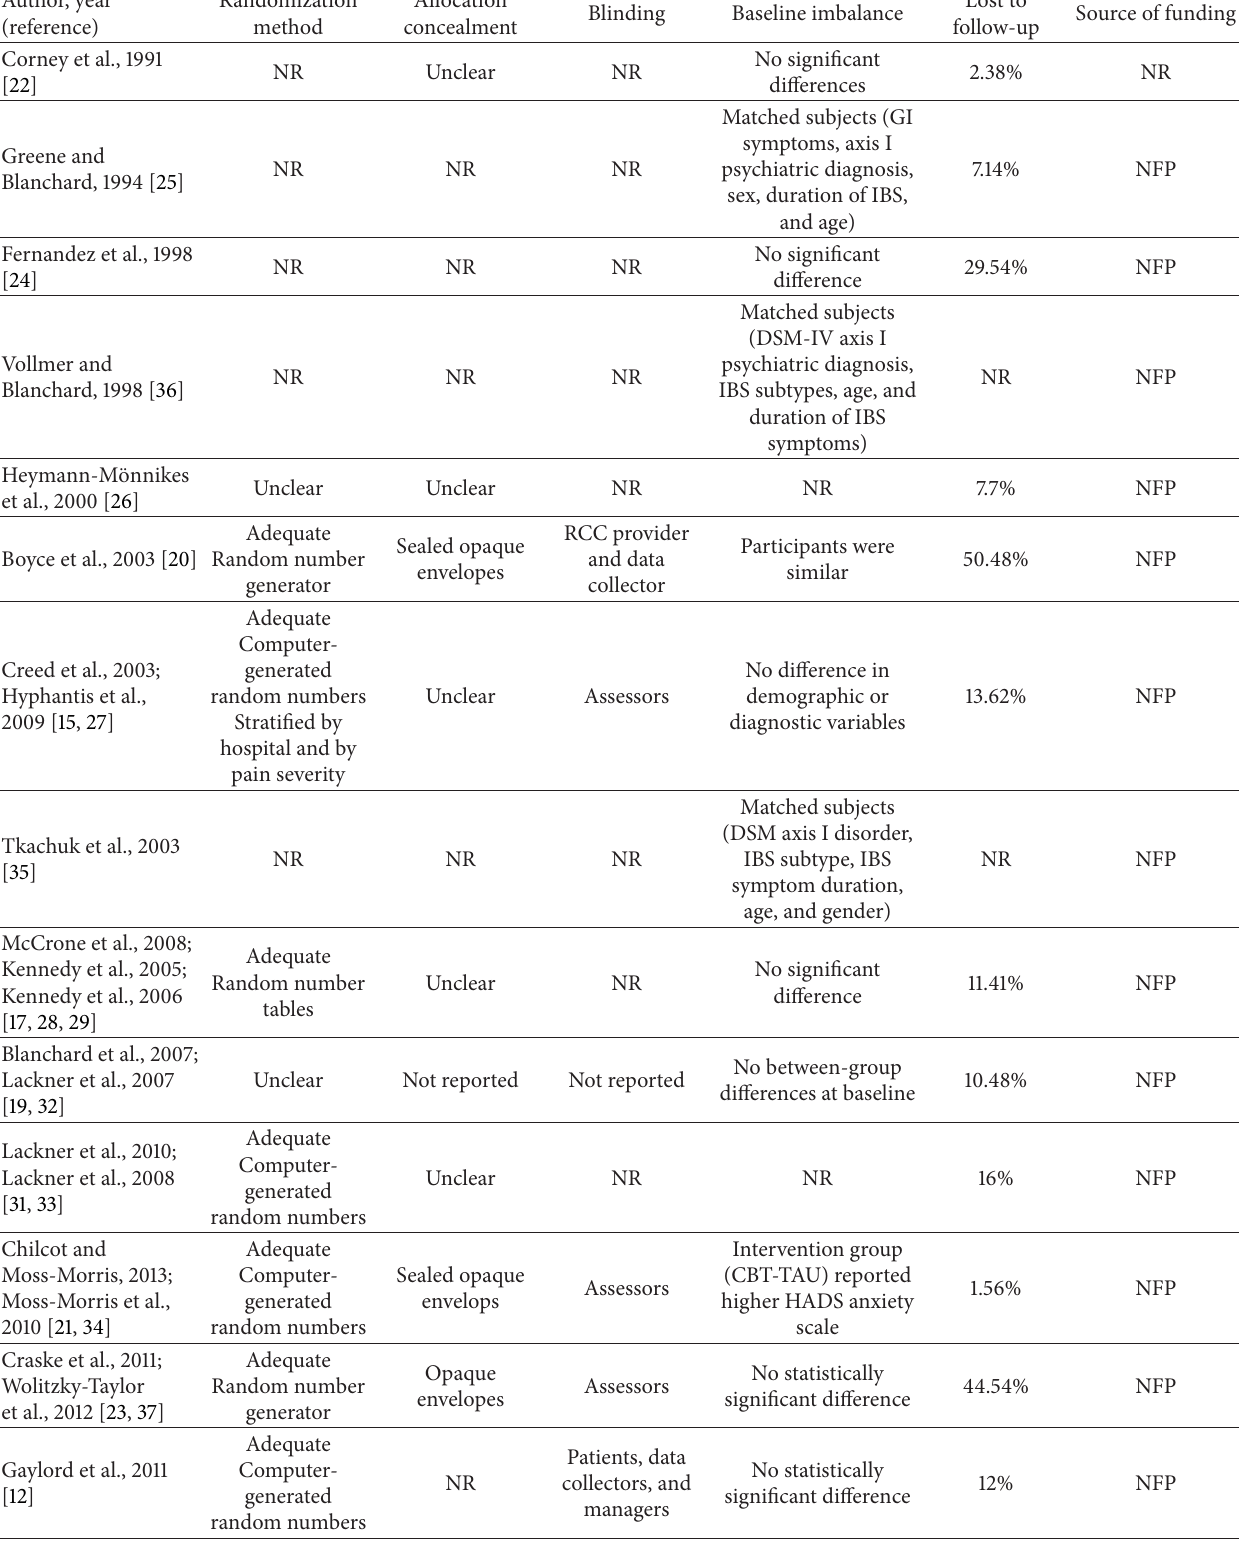
Table 1: Risk of bias assessment in the included